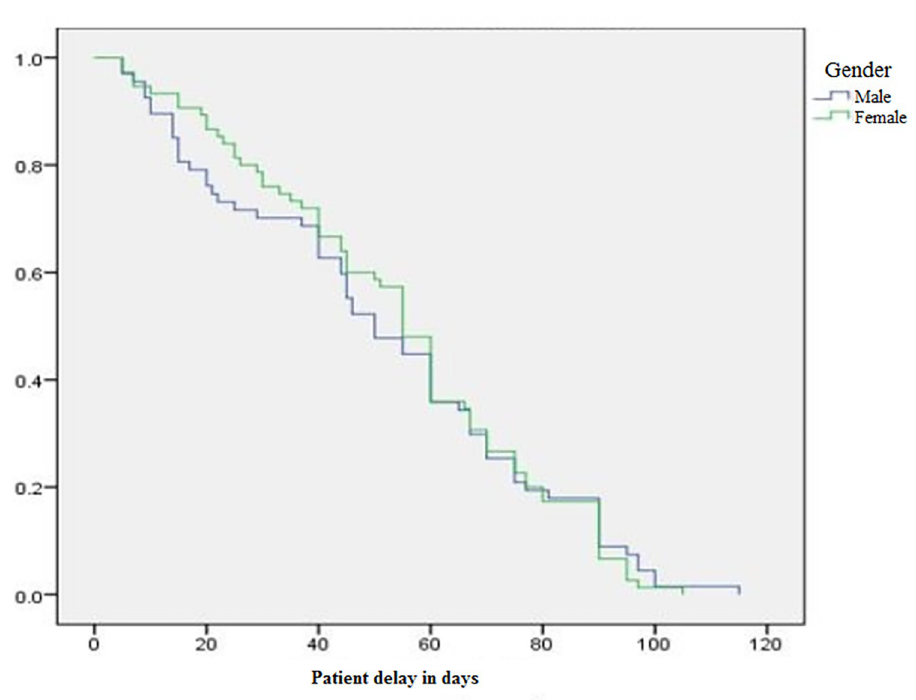
Fig 1. Kaplan–Meier curve of patient delays by gender of respondents.